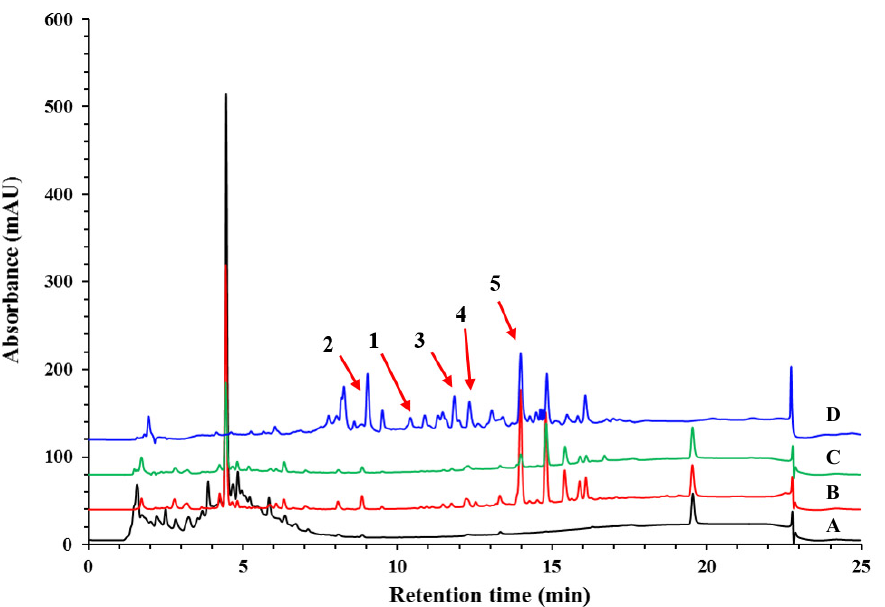
Figure 1. Component comparison of methanol extract of spores, methanol extracts of green tea with and without fermentation, and milk extract of fermented green tea. A : methanol extract of green tea (black); B : methanol extract of fermented green tea (red); C : milk extract of fermented green tea (green); D : methanol extract of spore (blue). 1 (variecolorin P); 2 ((-)-neoechinulin A); 3 (neoechinulin D); 4 (variecolorin G); 5 (echinulin).